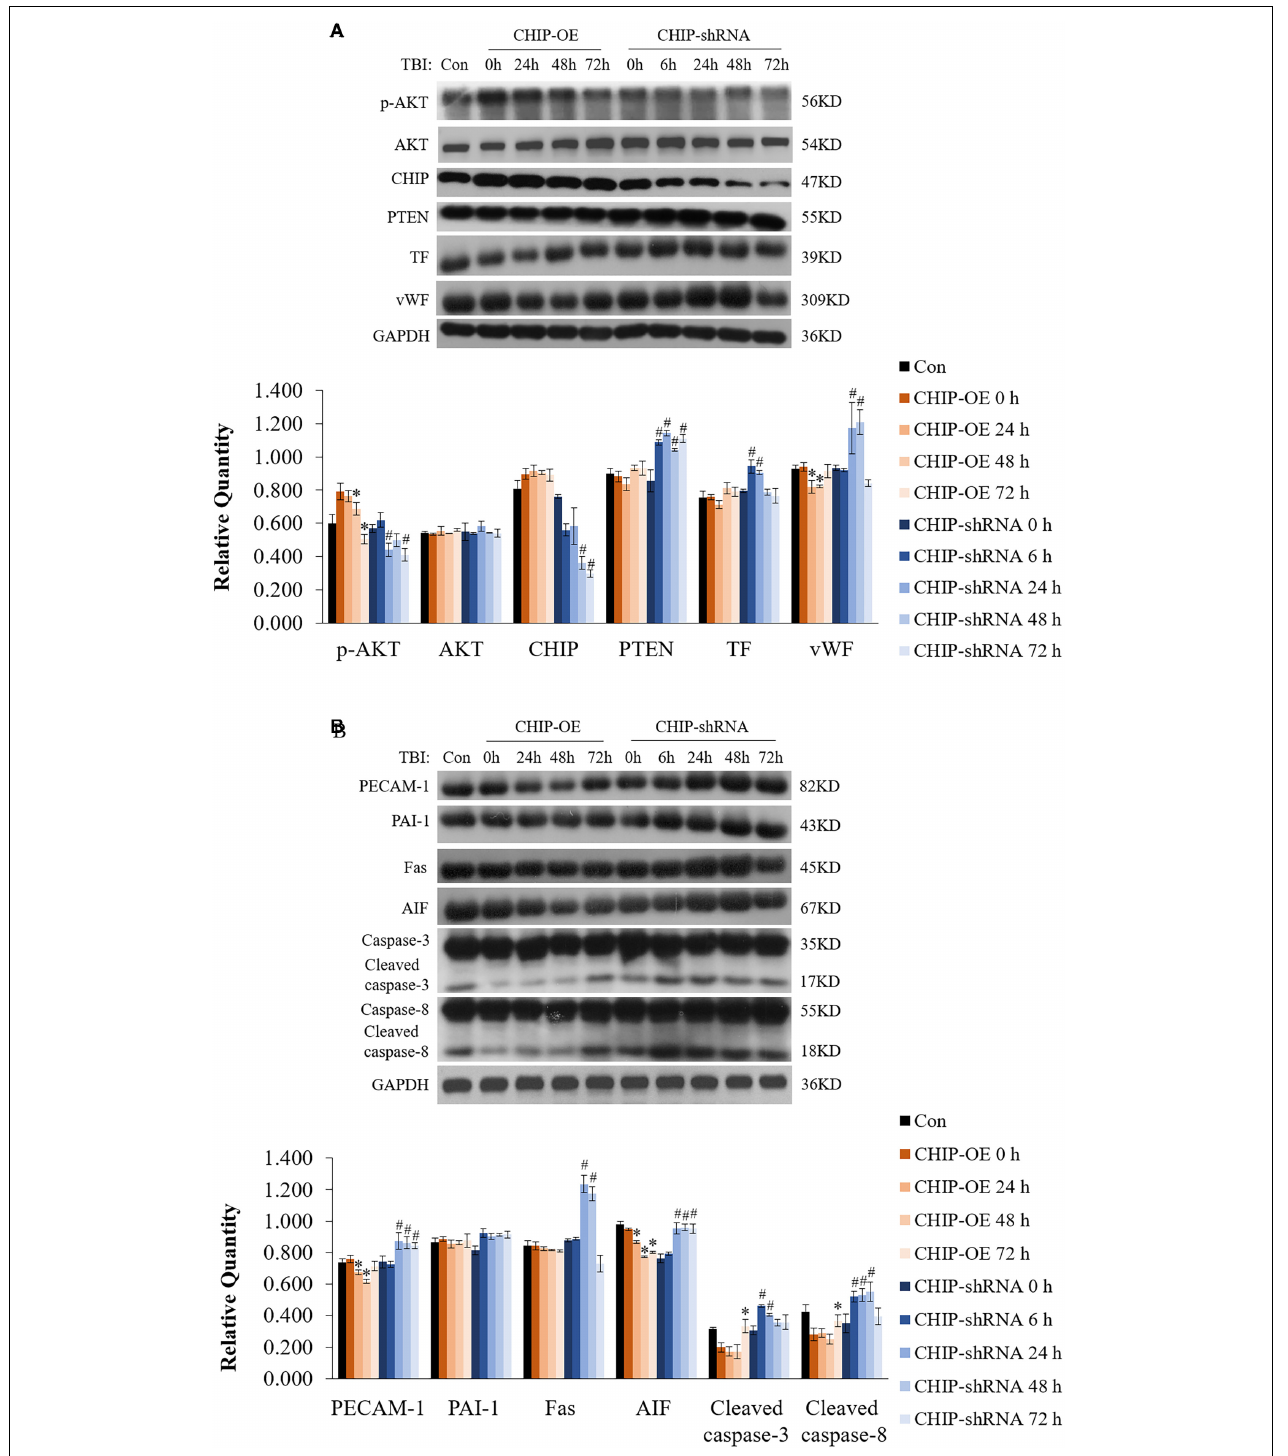
FIGURE 5 | C terminus of Hsc70-interacting protein (CHIP) overexpression suppressed procoagulant and apoptosis molecule expressions in pericontusional areas after in vivo traumatic brain injury (TBI). All groups were experienced with in vivo TBI treatment. CHIP-OE group of mice were killed after 0, 24, 48, and 72 h of CCI, and CHIP-shRNA group of mice were killed after 0, 6, 24, 48, and 72 h of CCI. Three-millimeter coronal tissue section from the ipsilateral cortex centering on the impact site was obtained immediately after killing. (A) Changes of CHIP, PTEN, and p-AKT levels in each group after in vivo TBI. (B) Changes of procoagulant molecules and apoptosis molecules in each group after in vivo TBI. Quantification of proteins was normalized to glyceraldehyde-3-phosphate dehydrogenase. ∗ p < 0.05 vs. the CHIP-OE-0h, # p < 0.05 vs. the CHIP-shRNA-0 h.